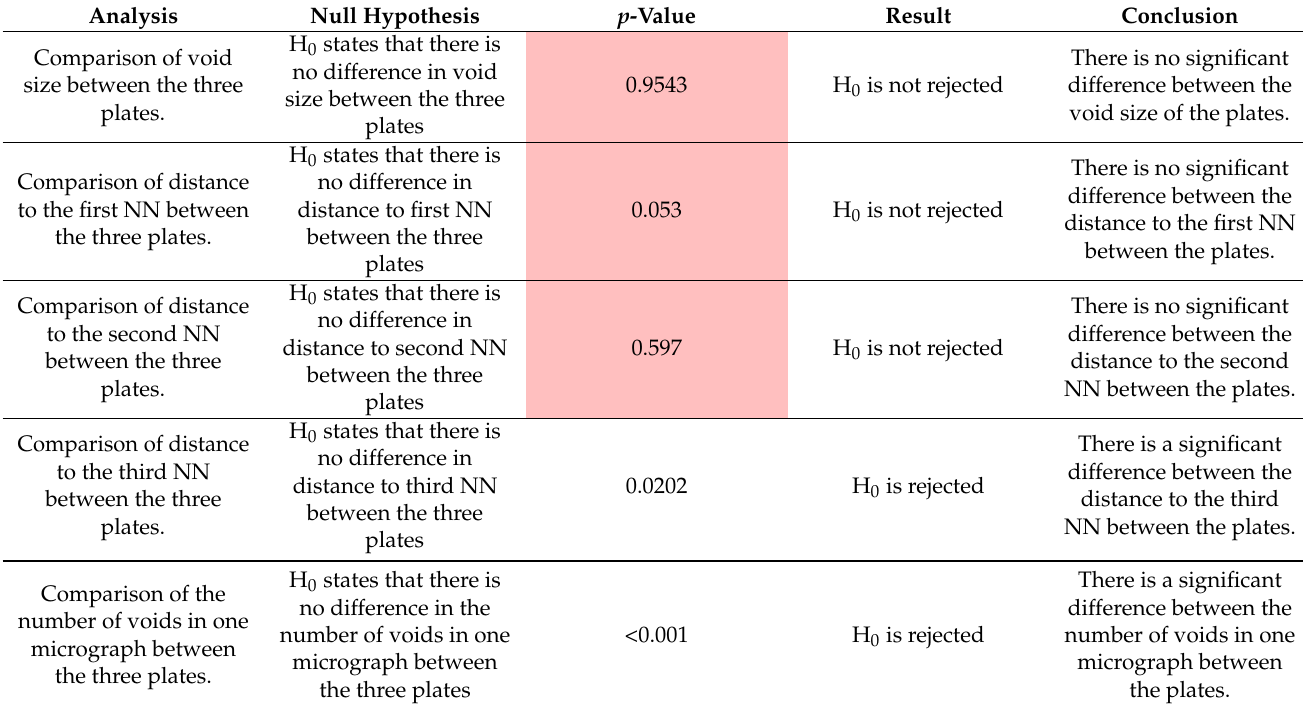
Table 19. Table for ANOVA analyzes.